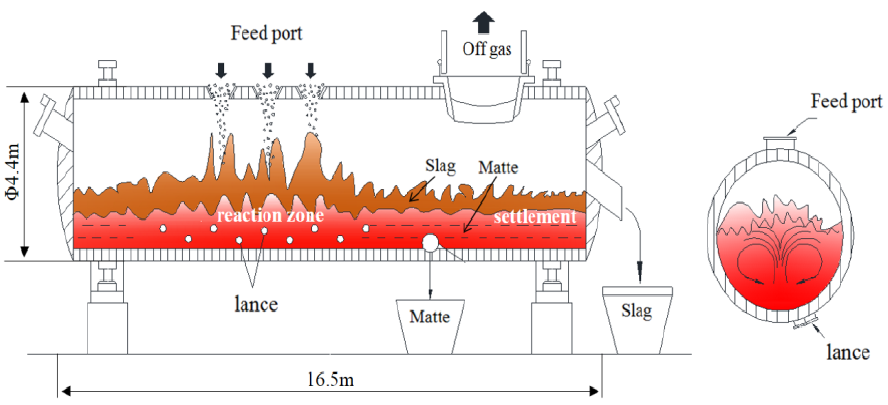
Figure 1. Schematic diagram of SKS (Shuikoushan) process.